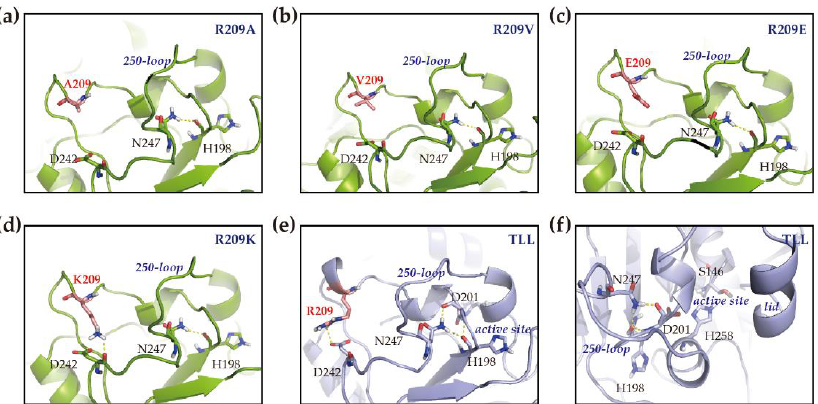
Figure 6. Structural modeling of R209 mutants and active site illustration of TLL. ( a – d ) Show the structures of R209A, R209V, R209E, and R209K, respectively; ( e ) displays the hydrogen bonding between D201 in the catalytic triad and nearby residues; ( f ) shows the relative position of the 250-loop, active site, and the lid domain of the TLL. Hydrogen bonding interaction and salt bridge interaction were labeled in yellow dash lines, residue 209 was labeled in red and its carbon atoms are colored in salmon.